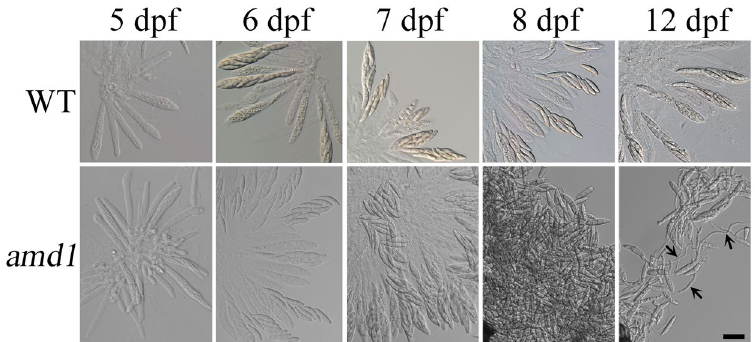
Figure 4. Ascus and ascospore development in the wild type and amd1 mutant. Perithecia of the wild-type strain PH-1 (WT) and the amd1 mutant were examined at 5, 6, 7, 8, and 12 days post fertilization (dpf). Bar = 20 μ m. Arrows mark the germinated ascospores in the mutant.